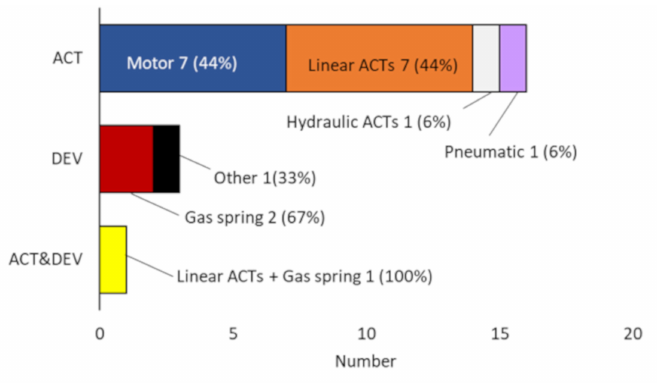
Figure 5. Summary of power unit classification in non-wearable